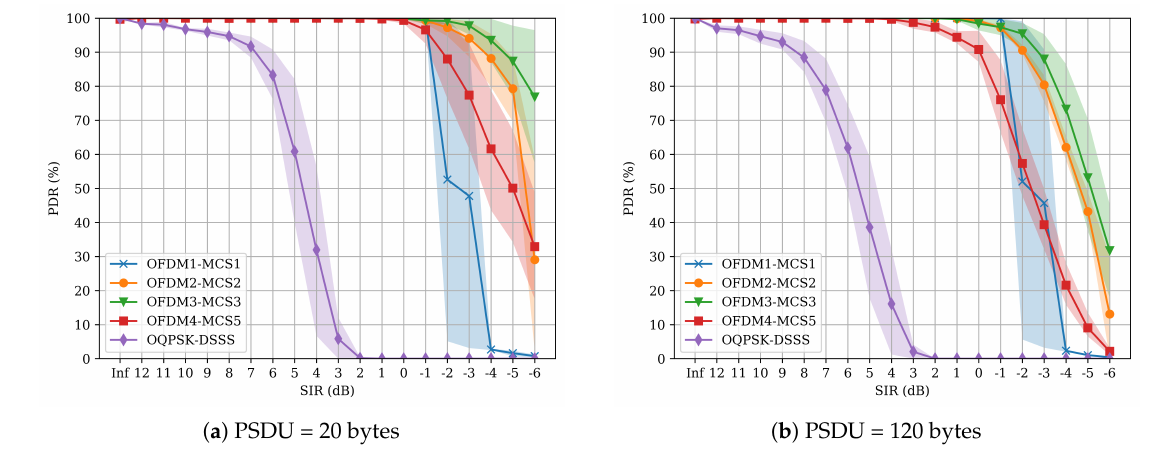
Figure 9. OQPSK-DSSS interference